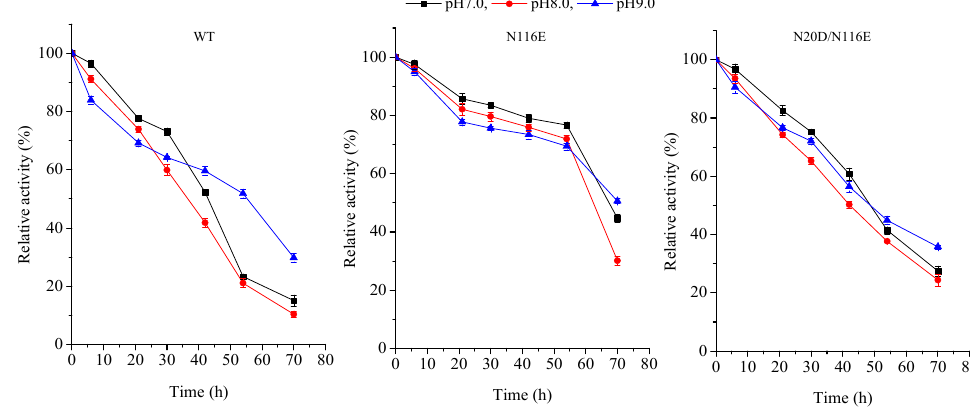
Figure 6. pH stability of BsNOX-WT and its mutants.